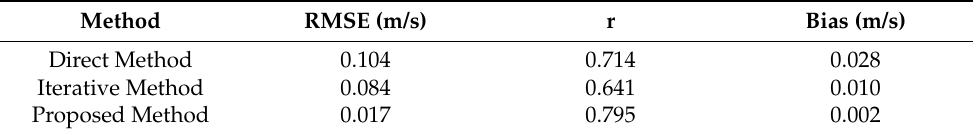
Figure 14. The velocity calculation results based on the proposed method: ( a ) the input velocity, ( b ) the calculated velocity obtained through the trained pix2pix network, and ( c ) the scatter density map of the input and calculated current velocities. Table 8. Statistics of the estimation results under different methods.